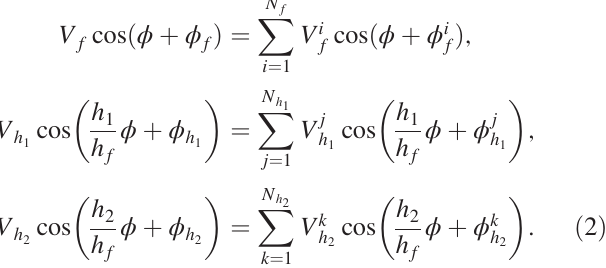
TABLE II. One set of the triple-frequency rf system parameters, noted that negative voltages of the fundamental and 2nd harmonic cavity is due to our definition to a synchrotron phase is π , rather than 0. The total beam power is I 0 U 0 ¼ 876 . 279 kW with a designed average current 200 mA. Parameters Fundamental 2nd Harmonic 3rd Harmonic